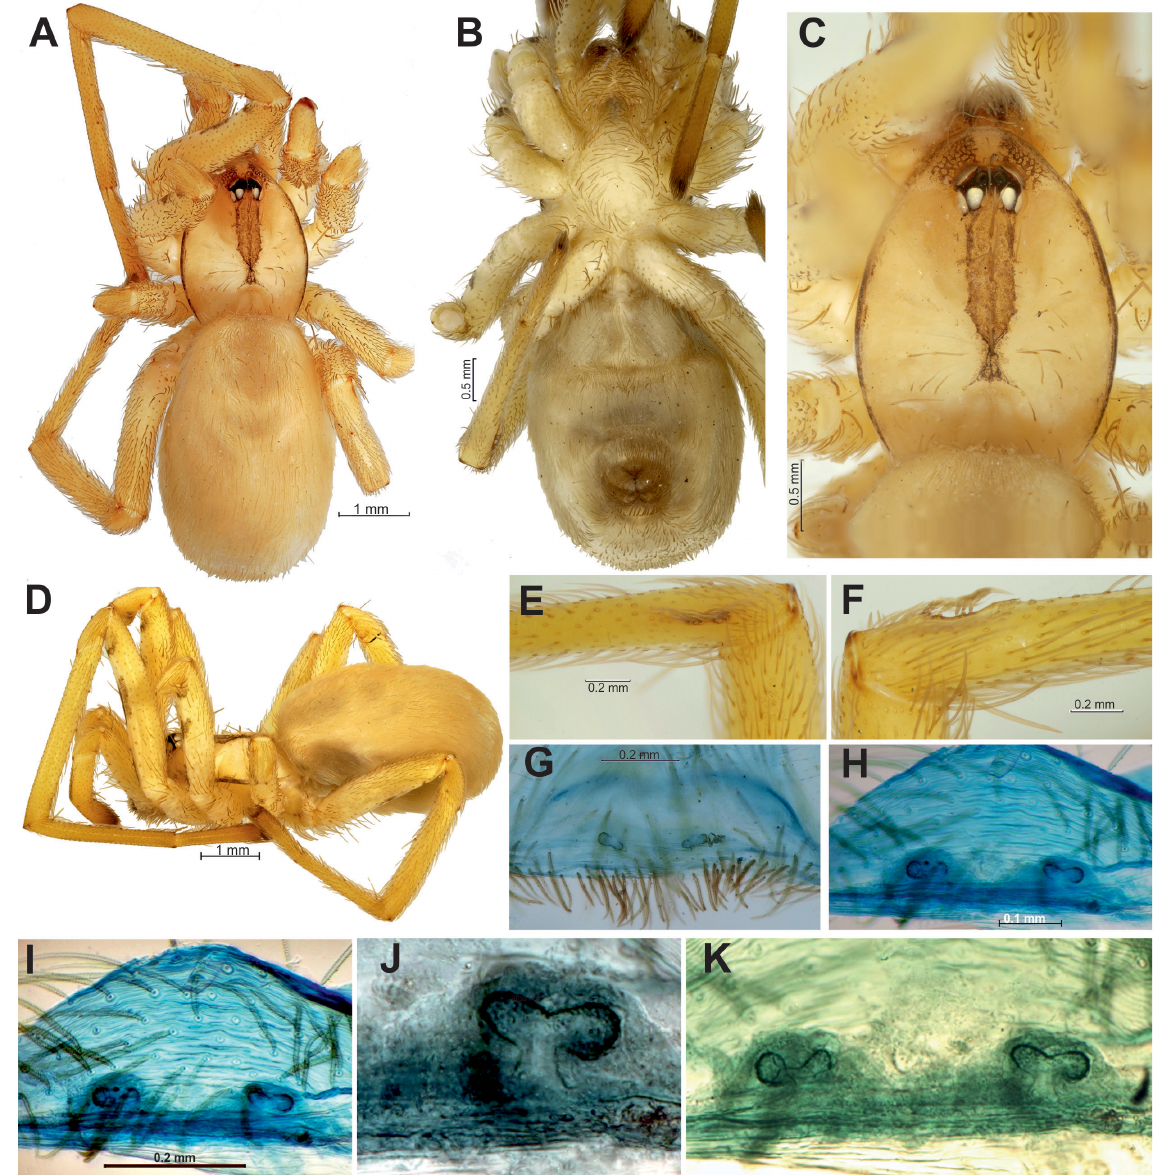
Fig. 14. Somatic characters and endogyne of Zaitunia afghana (Roewer, 1962), holotype, ♀ . A–B . Habitus, dorsal and ventral. C . Prosoma, dorsal. D . Habitus, lateral. E–F . Calamistrum from above and lateral. G – I , K . endogyne, dorsal. J . right receptacle, dorsal. Scale bars: a, D = 1.0 mm; B–C = 0.5 mm; e–G, i = 0.2 mm; H = 1.0